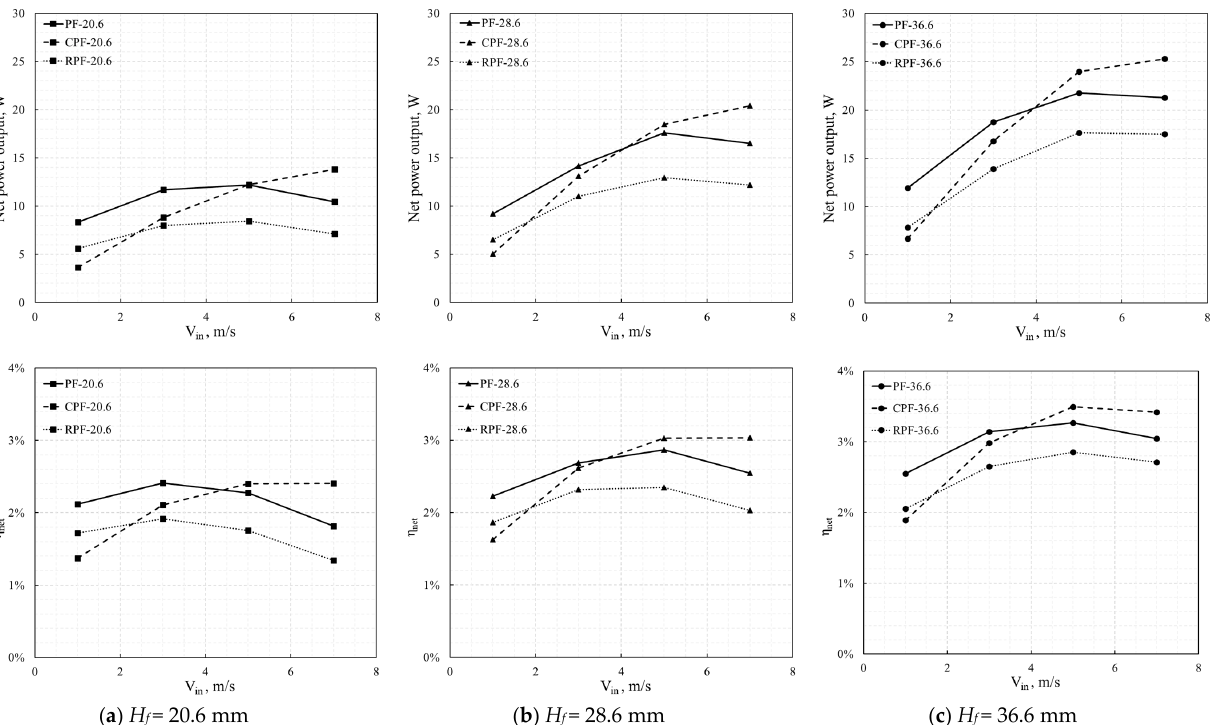
Figure 16. Maximum net power output (upper) and net efficiency (lower) of TEG module with different fin structures and inlet velocity of flue gas ( T in = 600 °C).